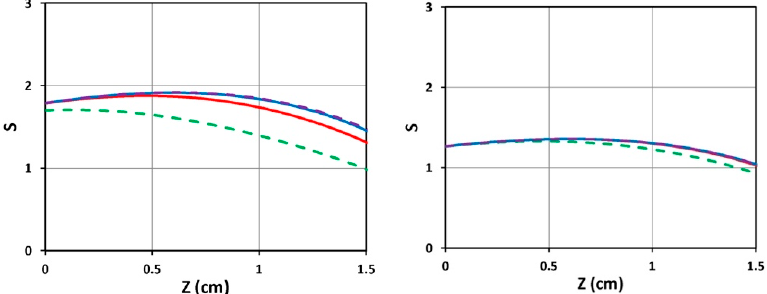
Figure 4. Spatial profiles of S for various exposure time t = (100, 200,3 00, 400) s shown by (green, red, blue, purple) curve, for light intensity I 0 = 10 (left figure ) and 20 ( right figure ) mW/cm 2 , and D = 1.0 cm, C 0 = 2 mM.